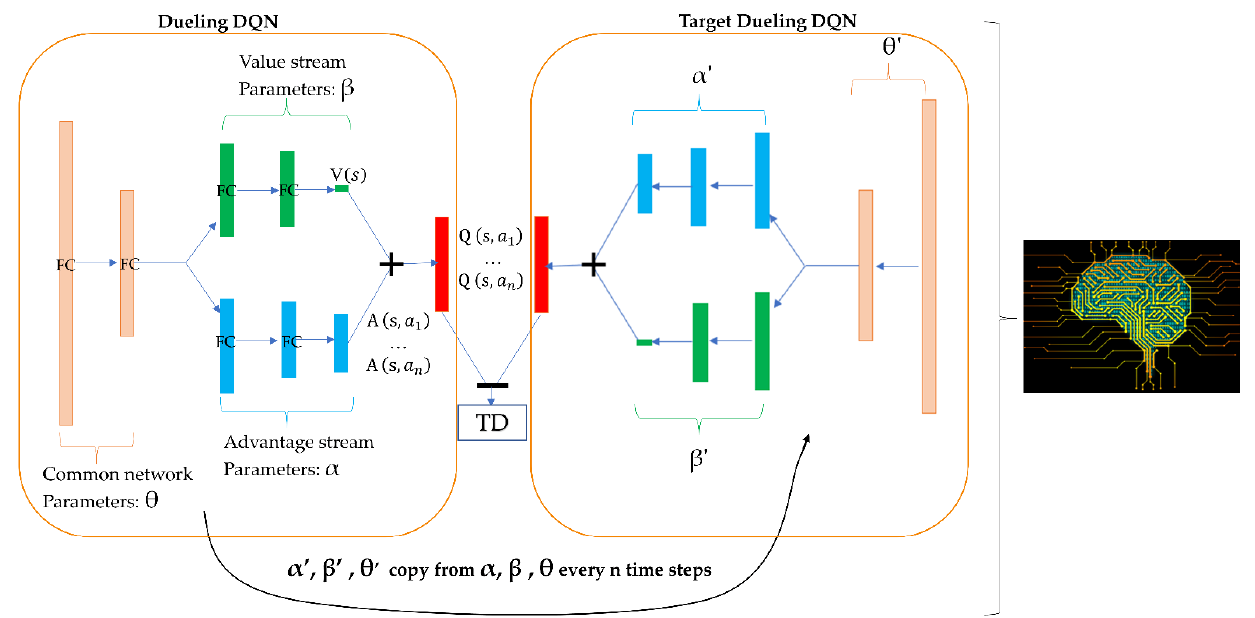
Figure 8. Architecture of the applied deep Q-learning network (ADQN). TD is the temporal difference error.